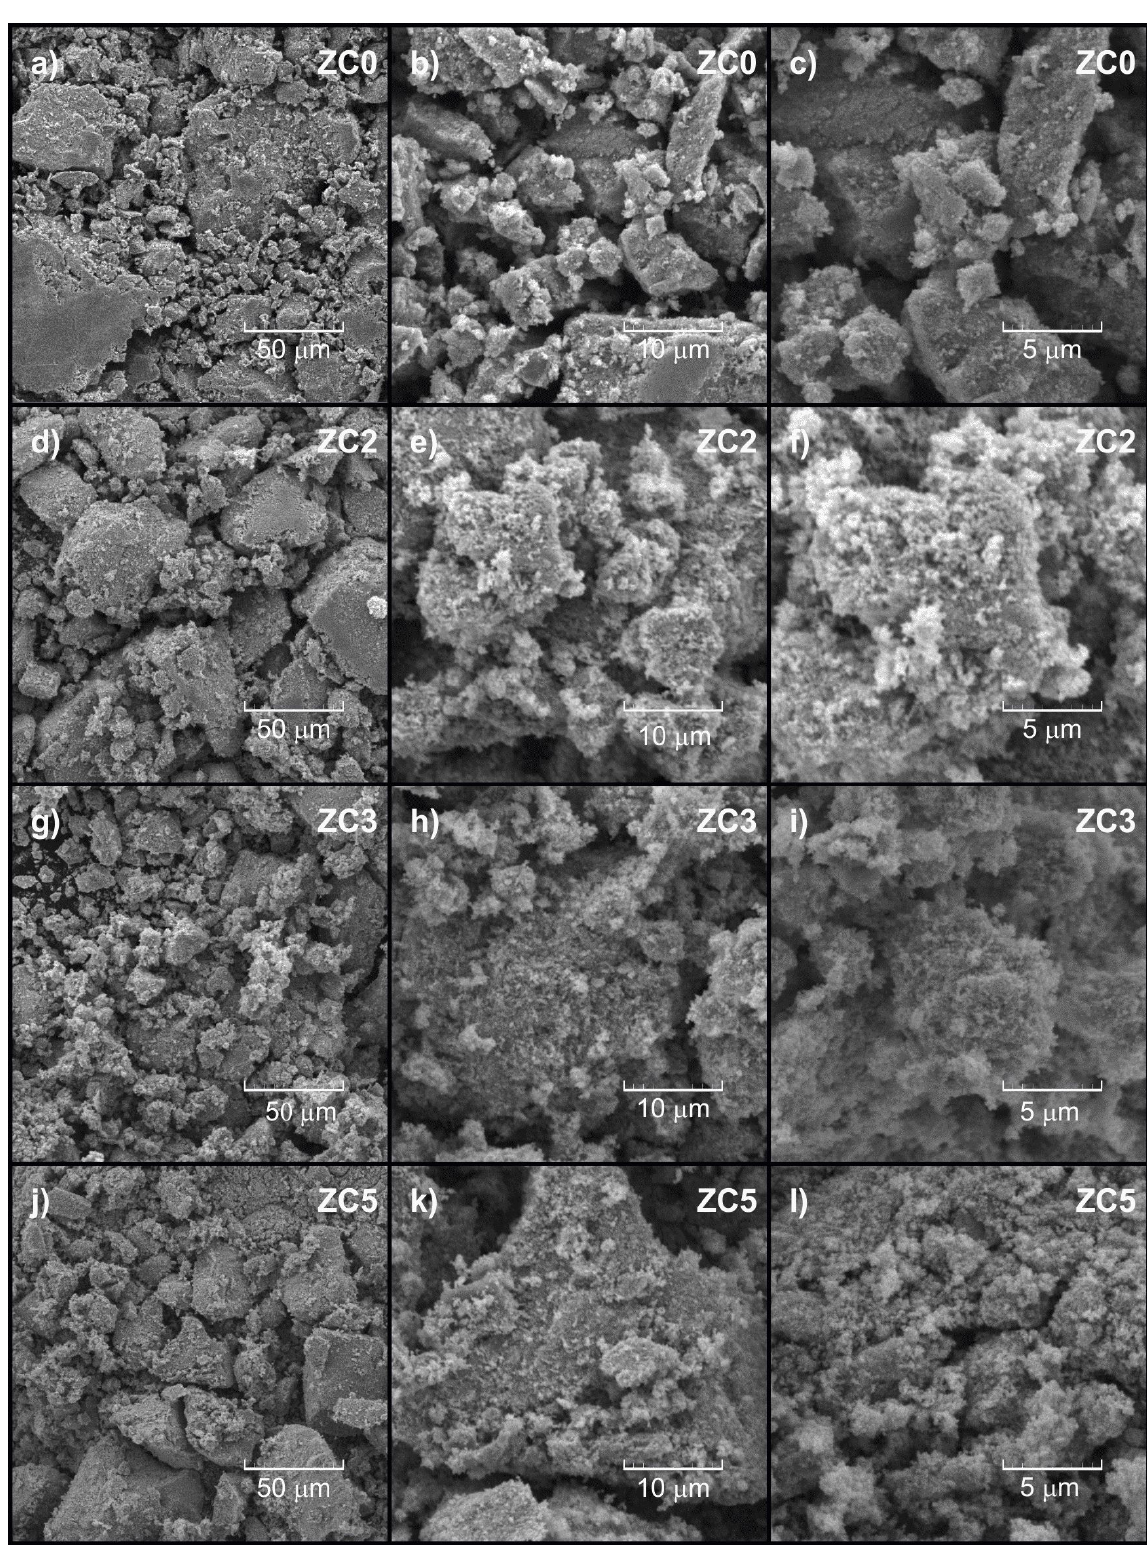
Figure 7: SEM micrographs of samples ZC0 (a, b, c), ZC2 (d, e, f), ZC3 (g, h, i) and ZC5 (j, k,